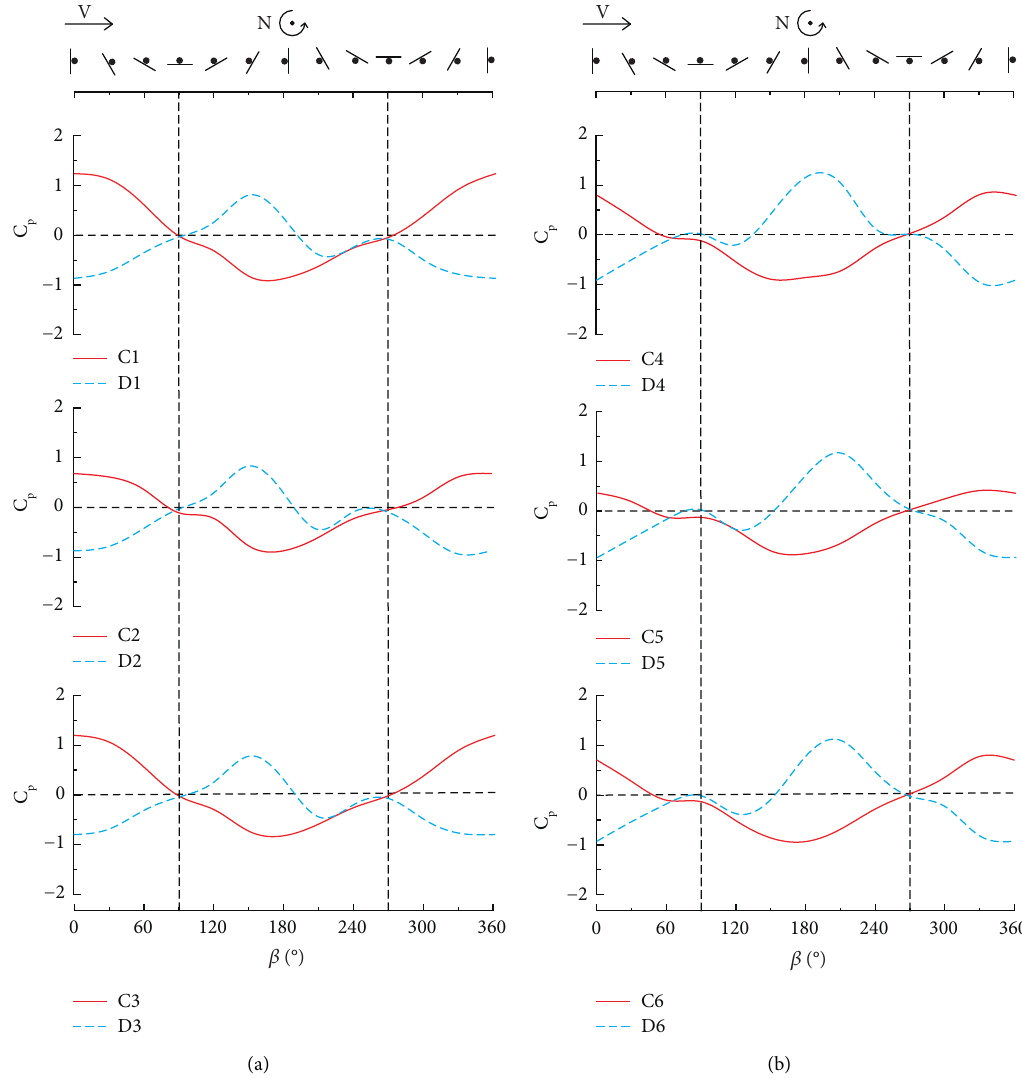
Figure 21: Pressure coefficient of the surface monitoring points with respect to azimuth angle as the porous plate antenna rotates, β � 0–360 ° , and K � 0.34. (a) Monitoring points 1, 2, and 3; (b) monitoring points 4, 5, and 6 (C represents the front and D represents the